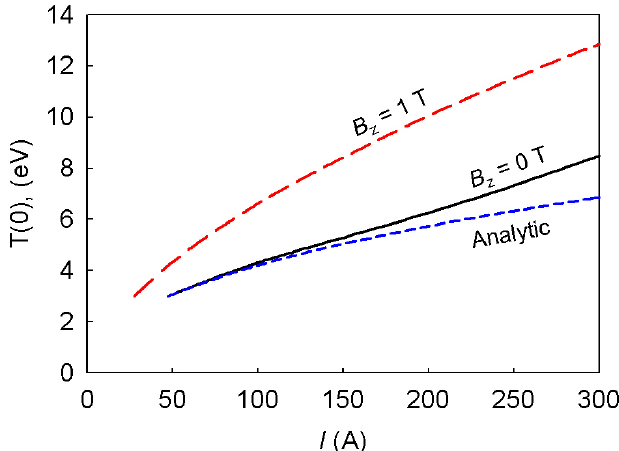
FIG. 5. (Color) Quasistatic model predictions for plasma density (cid:7) 250 (cid:2) m and pressure versus radius for I (cid:7) 100 A with R 0 (cid:7) 4 (cid:6) 10 16 cm (cid:3) 3 . B and n 0